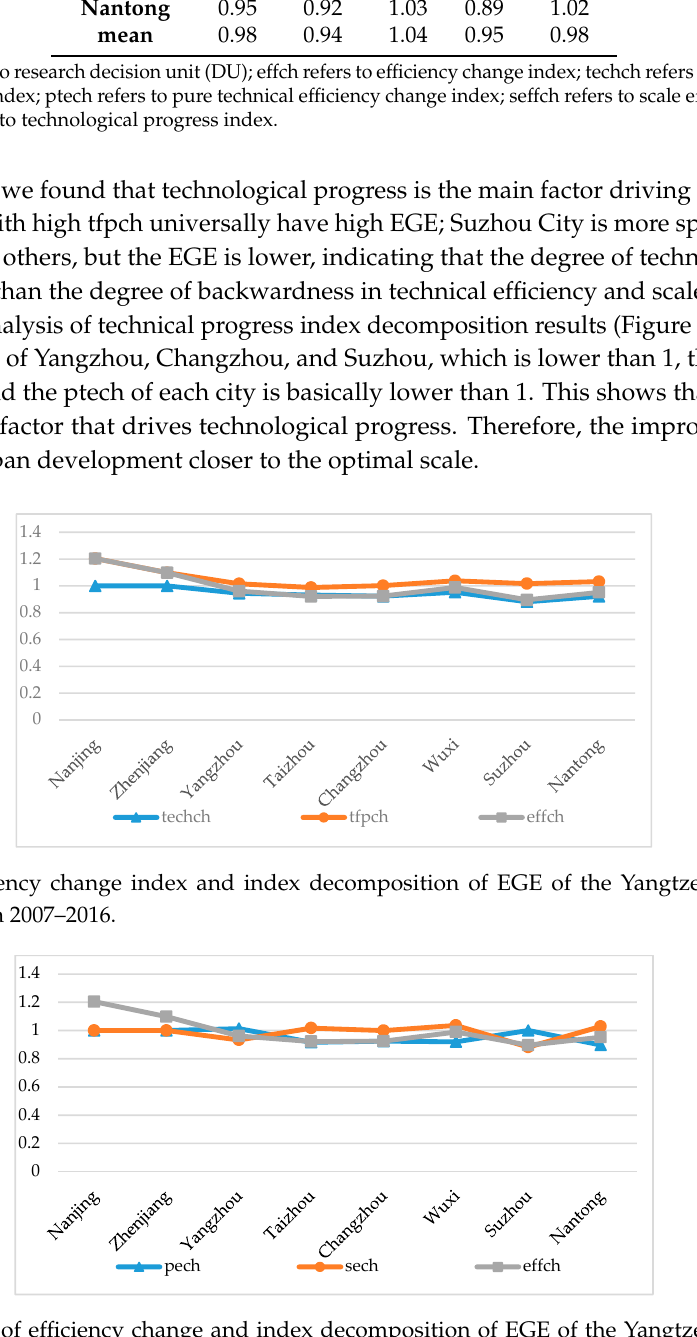
Figure 4. Index of efficiency change and index decomposition of EGE of the Yangtze River urban agglomeration in